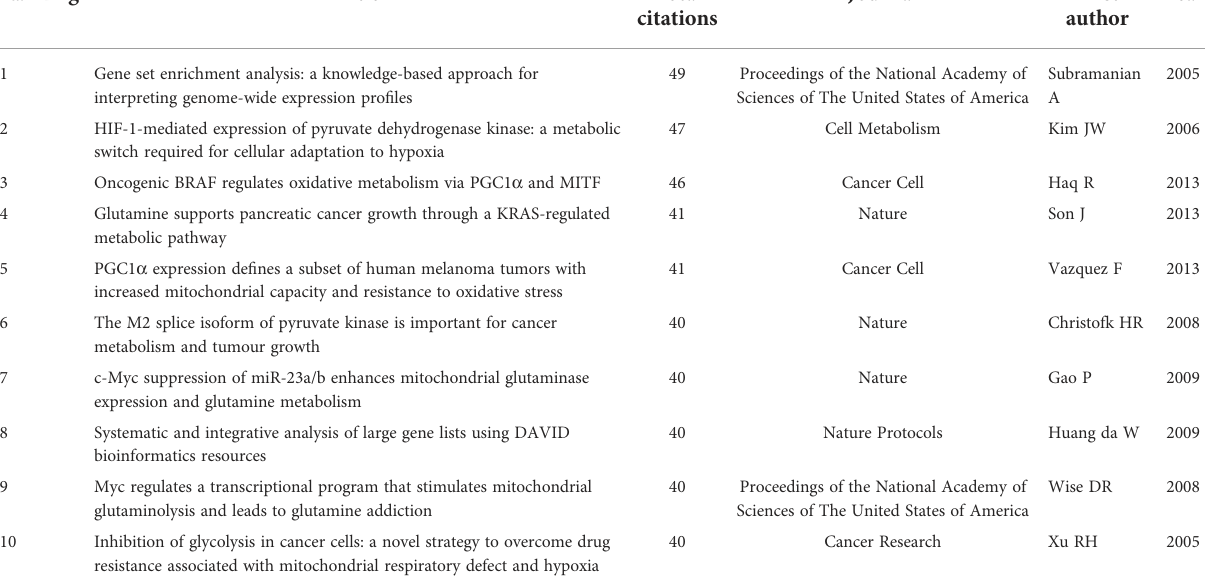
TABLE 2 The top 10 co-citation of original